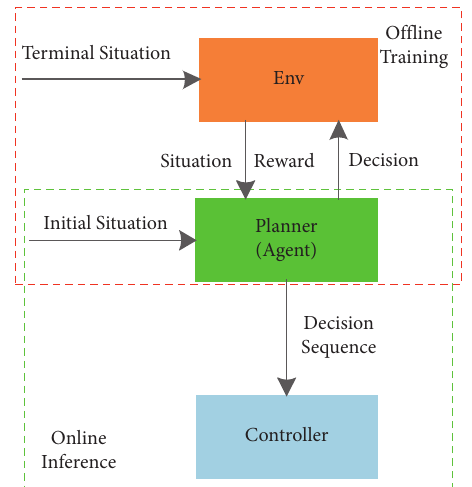
Figure 6: General architecture of intelligent planning.